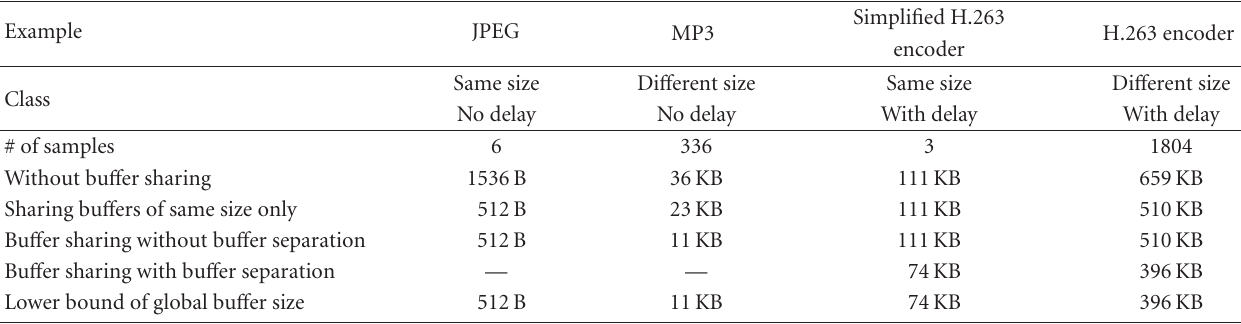
Table 1: Comparison of bu ff er memory requirements for three real-life examples.